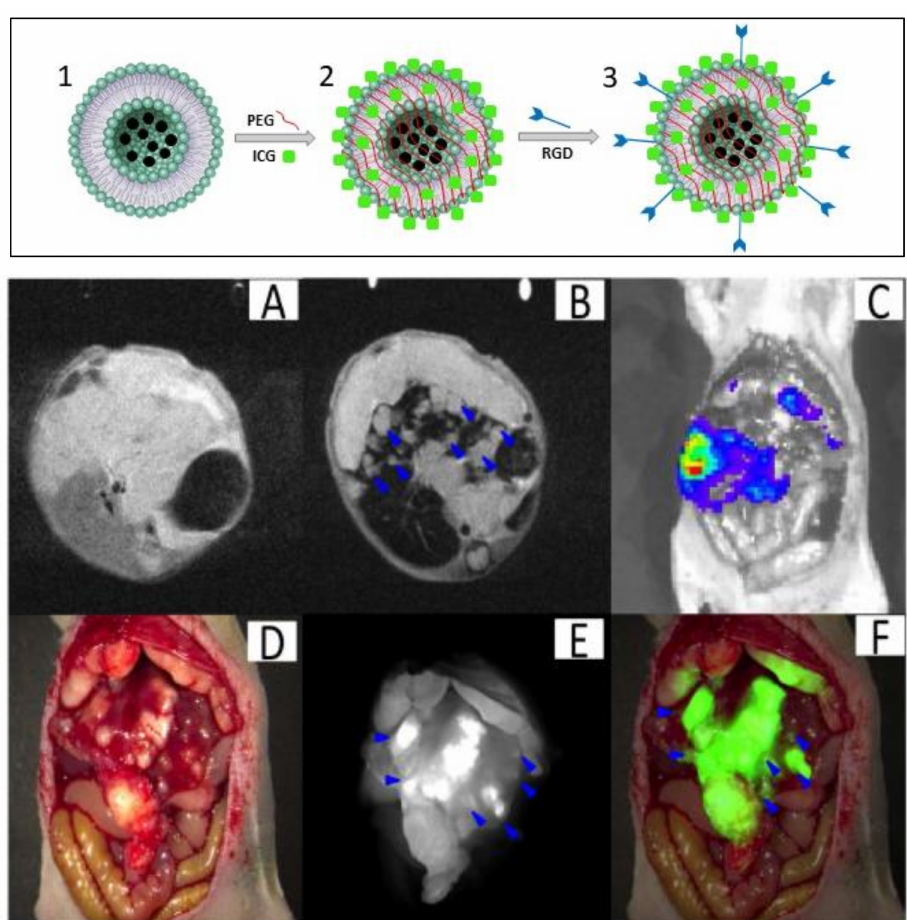
Figure 9. Synthesis of SPIO@liposome-ICG-RGD (upper panel). (1) SPIO nanoparticles encapsulated in liposomes. (2) Magnetoliposome functionalized with ICG molecules. (3) Conjugation of RGDs peptide; orthotopic liver tumors with intrahepatic metastasis (lower panel). ( A ) The MRI image before SPIO@liposome-ICG-RGD injection. ( B ) The MRI signal was decreased in normal liver tissue (CNR: 14.6 ± 9.9) after targeting probe injection and the disseminated tumor nodes (0.9 ± 0.5 mm) (blue arrows) can be clearly defined. ( C ) Liver tumors confirmed by bioluminescence imaging. ( D ) Surgical guidance by intraoperative FMI-NIR. ( E ) The implanted liver tumor tissue (0.7 ± 0.3 mm) (blue arrows) exhibits obvious contrast (TBR: 2.3 ± 0.5) in colour and texture with normal liver tissues. ( F ) Merged colour and fluorescence image. Figure adapted from [94], Copyright 2017